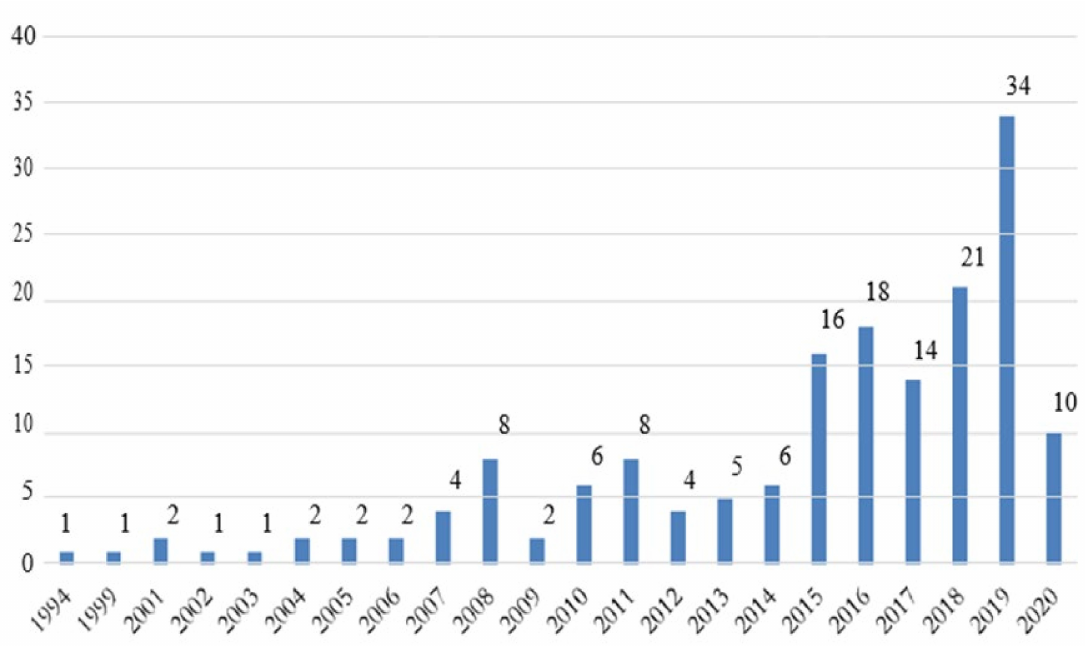
Figure 1. Articles concerning the presence of women on boards of directors published each year. Source: Web of